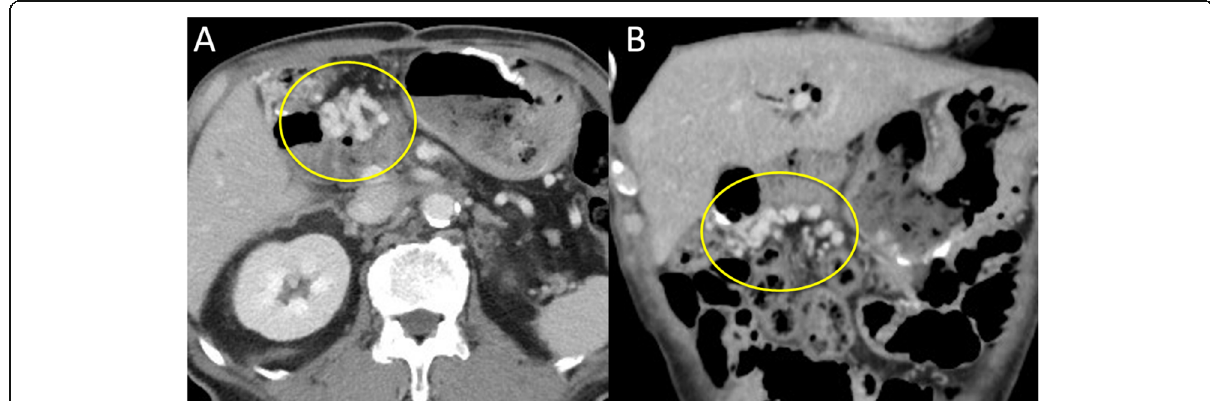
Fig. 2 Findings of enhanced computed tomography (CT). a Axial imaging. b Coronal imaging. CT scan did not show obstruction or stenosis of the reconstructed PV, but it revealed transverse colonic varices (yellow circles)